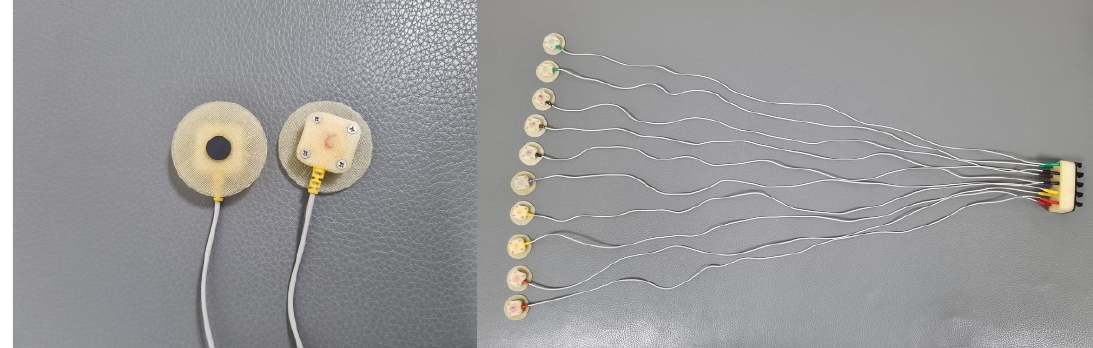
Figure 1. Graphite-based electrocardiogram electrodes.